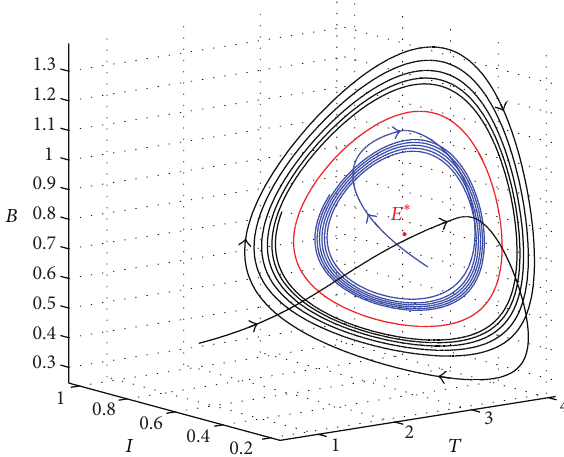
Figure 3: Delay can destabilize 𝐸 ∗ and lead to Hopf bifurcation when 𝜏 increases past a critical value 𝜏 0